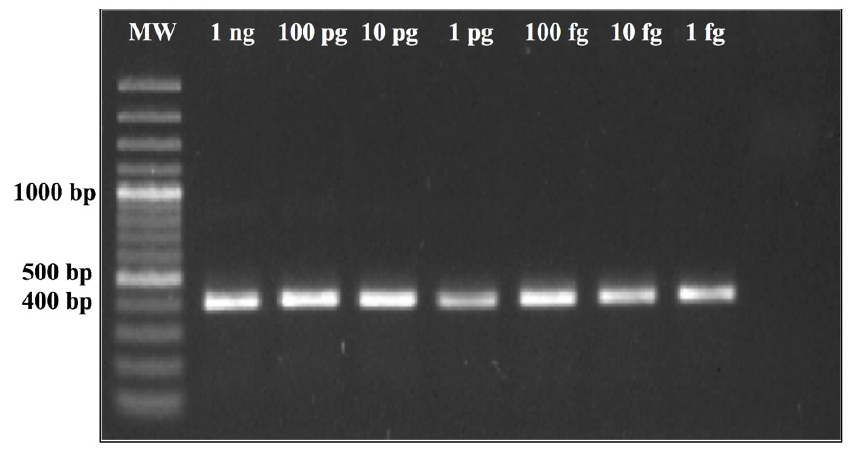
Figure 2. PPK control plasmid serial dilutions with nontemplate control (NTC).